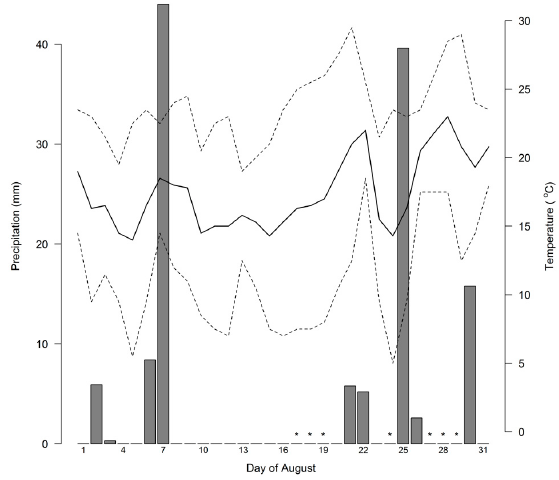
Figure 2. Haliburton regional weather data for August 2013. Lines indicate daily range (dashed) and mean (solid) temperatures. Bars indicate magnitude of rainfall. Points marked with asterisks along the x-axis indicate dates of flux observations.